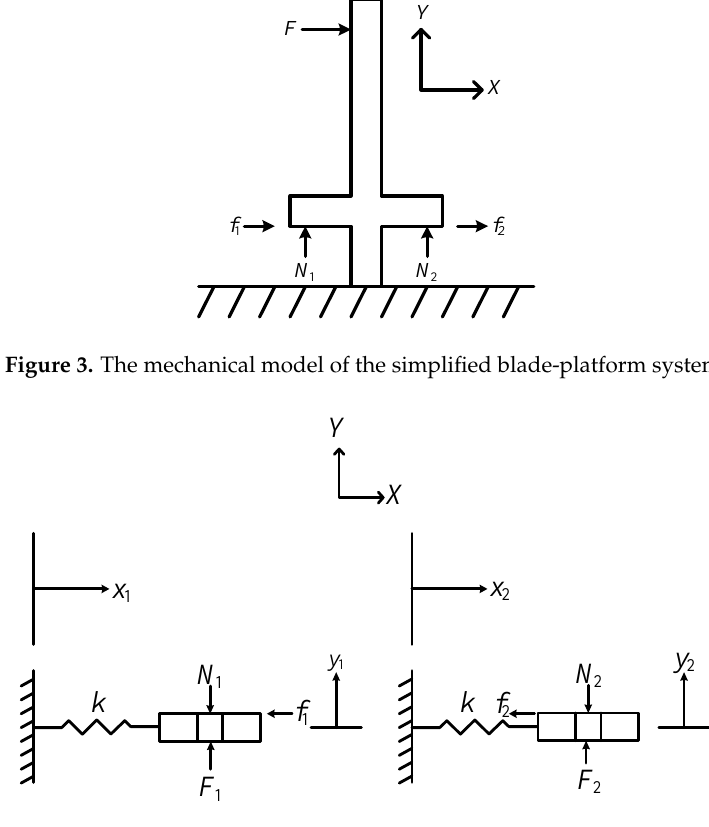
Figure 4. The mechanical model of the under-platform dampers.